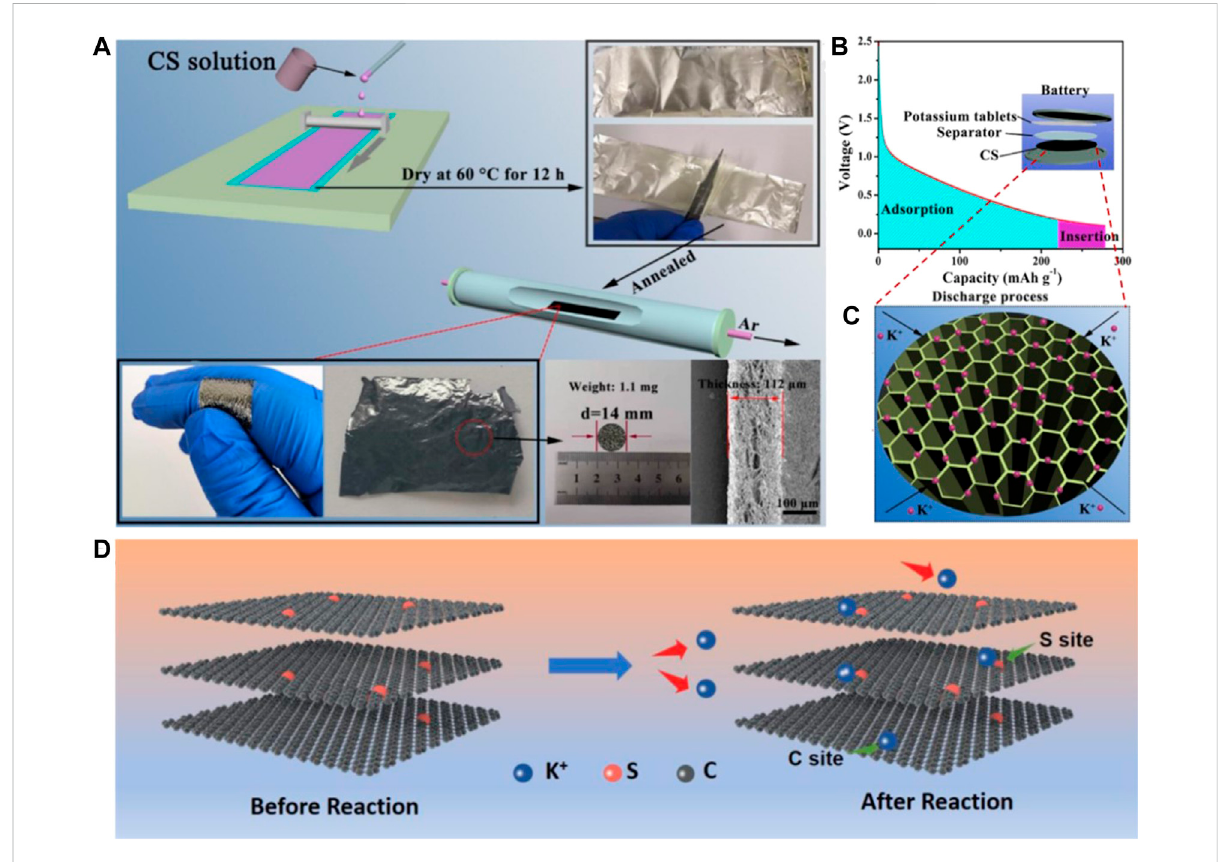
FIGURE 2 (A) Schematicrepresentationofthepreparationprocessofa fl exibleCS-derivedcarbonmembrane. (B,C) Illustrationofthestoragemechanism of K + in the porous CS-derived carbon membrane. Reproduced with permission (Wang et al., 2021b). Copyright 2021 Elsevier Ltd. (D) Possible K + storage mechanism for S-RGO sponges. Reproduced with permission (Li et al., 2018a). Copyright 2019